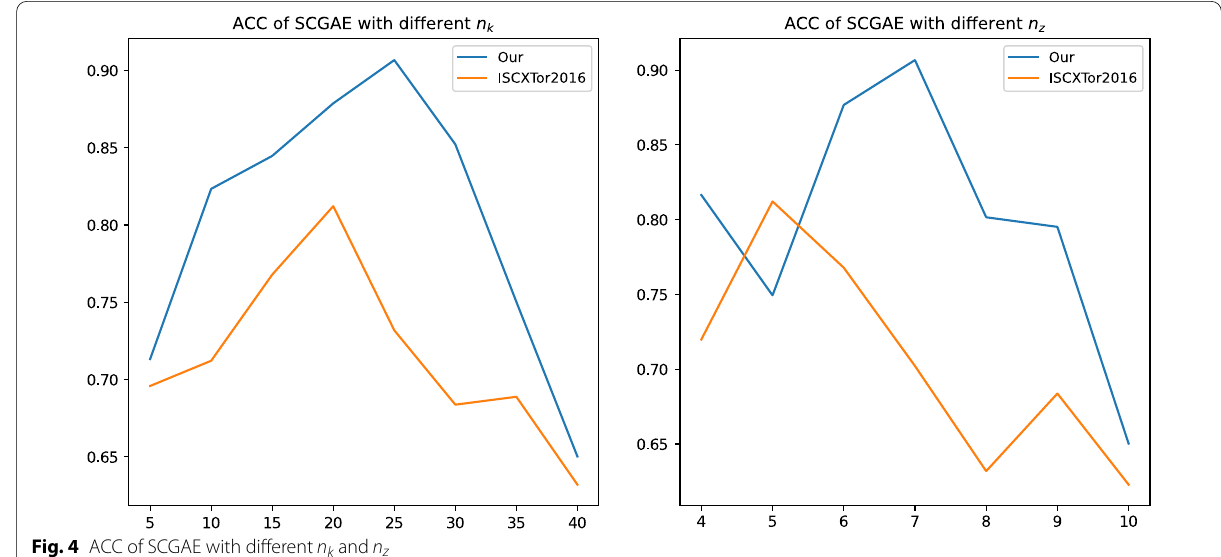
Fig. 4 ACC of SCGAE with different n k and n